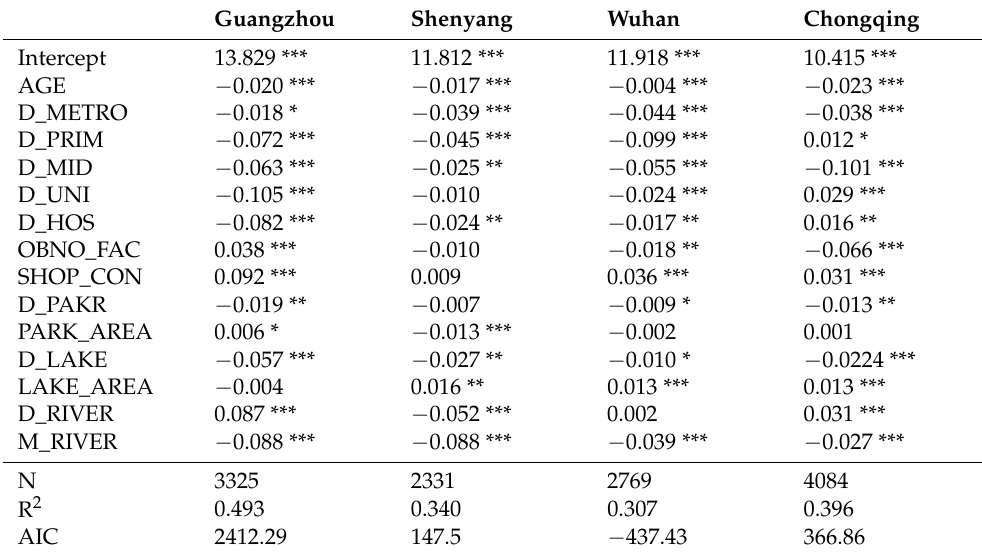
Table A10. OLS estimation results for Model II.